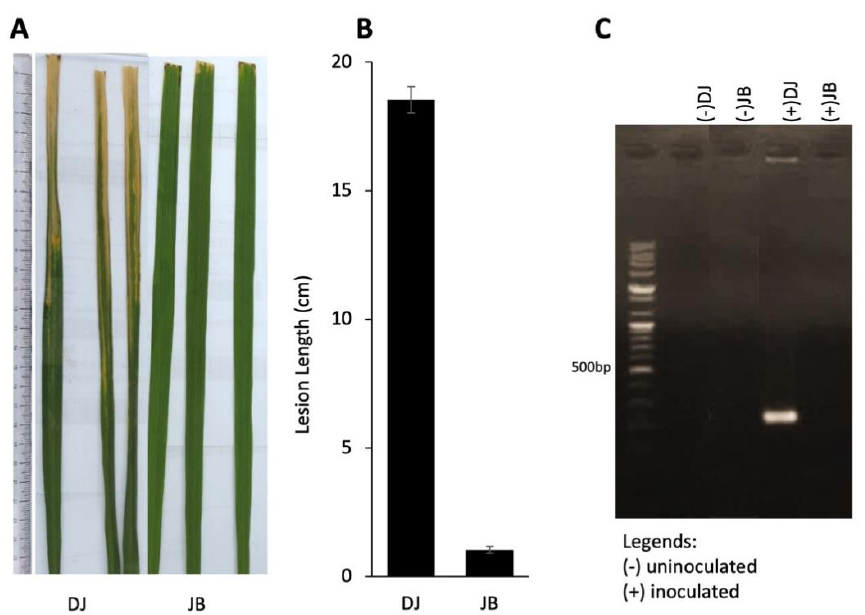
Figure 1. Phenotypic reaction of Dongjin (DJ) and Jinbaek (JB) to X. oryzae pv. oryzae race K2 inoculation. ( A ) The phenotype of two genotypes infected with Xoo at 14 dpi. ( B ) Average lesion length of blight symptoms measured in cm taken at 14 dpi. Data presented are treatment means ± SD. ( C ) Genomic PCR detection of putative glycosyltransferase (AF169030.1; 420 bp), which indicates the presence of Xoo , in the rice leaf tissue of DJ and JB 5 dpi. Band indicates the presence of Xoo ; no band means absence of Xoo .